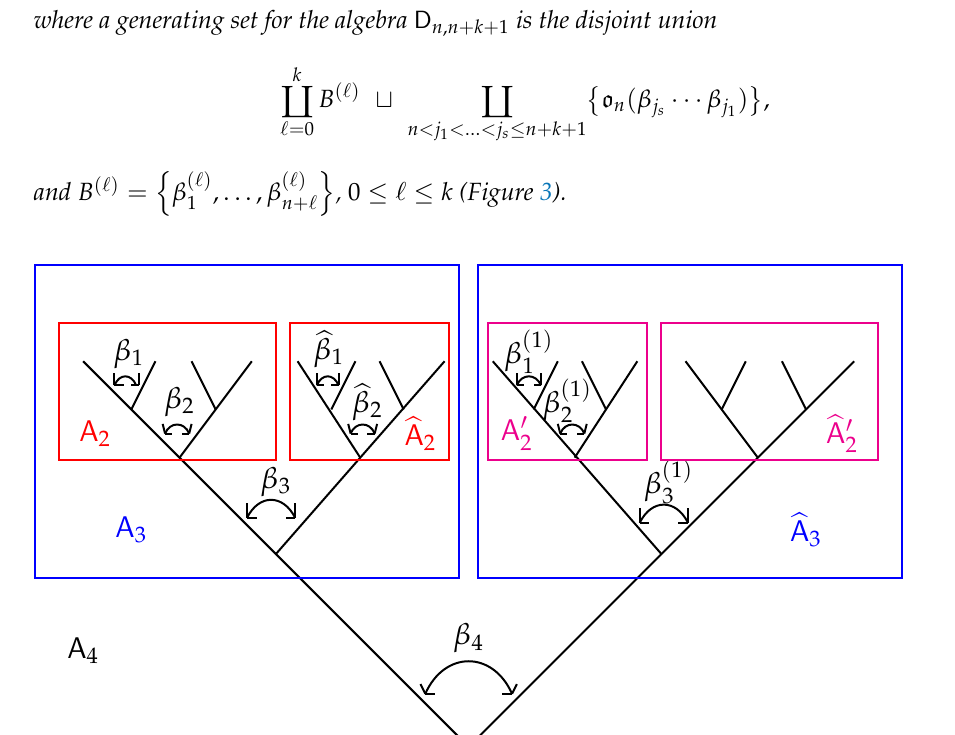
Figure 3. The algebra End 2 ( Ind 2 ) decomposes as End 2 ( Id ) ⊗ D 2,4 . A generating set for D 2,4 is (cid:98) B ∪ B ( 1 ) ∪ { o 2 ( β 3 ) , o 2 ( β 4 ) , o 2 ( β 4 β 3 ) } , where (cid:98) B = { (cid:98) β 1 , (cid:98) β 2 } and B ( 1 ) = { β